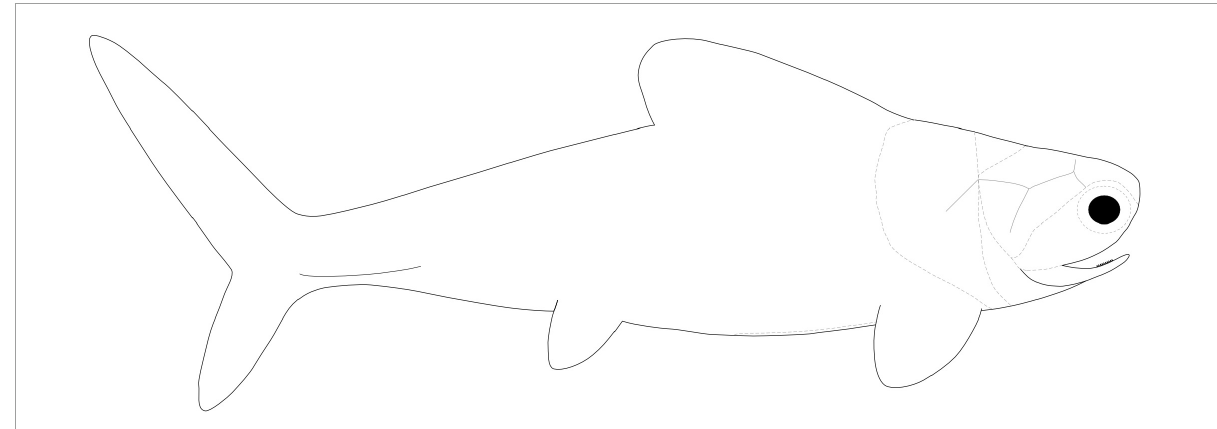
FIGURE9 Body outline reconstruction of Amazichthys trinajsticae gen. et sp. nov. based on the holotype AA.MEM.DS.8, skull roof PIMUZ A/I 5141 and PIMUZ A/I